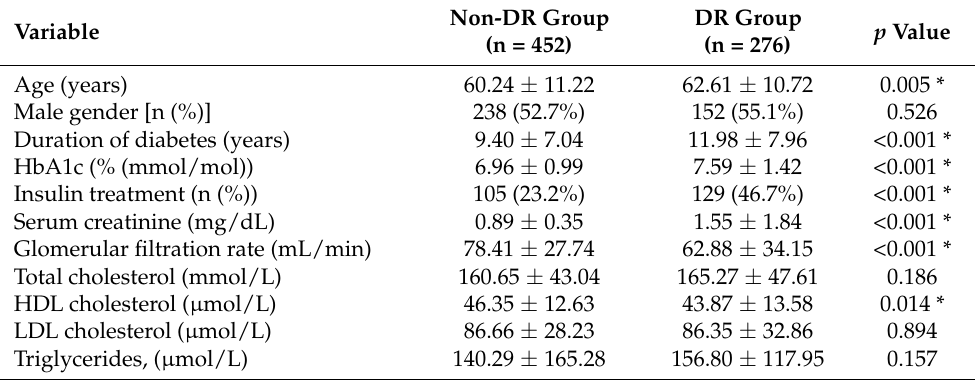
Table 1. Clinical and laboratory characteristics of patients with diabetic retinopathy and non-diabetic retinopathy.